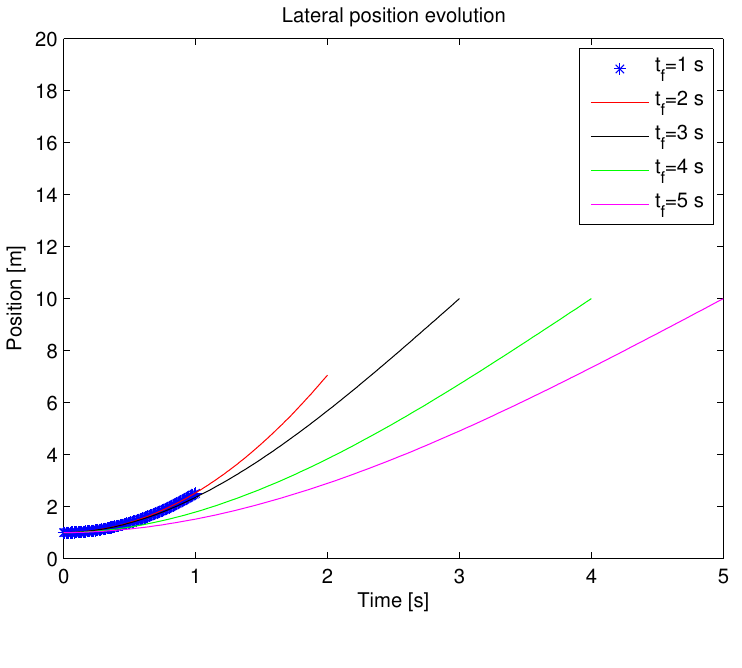
for different t D 2 f